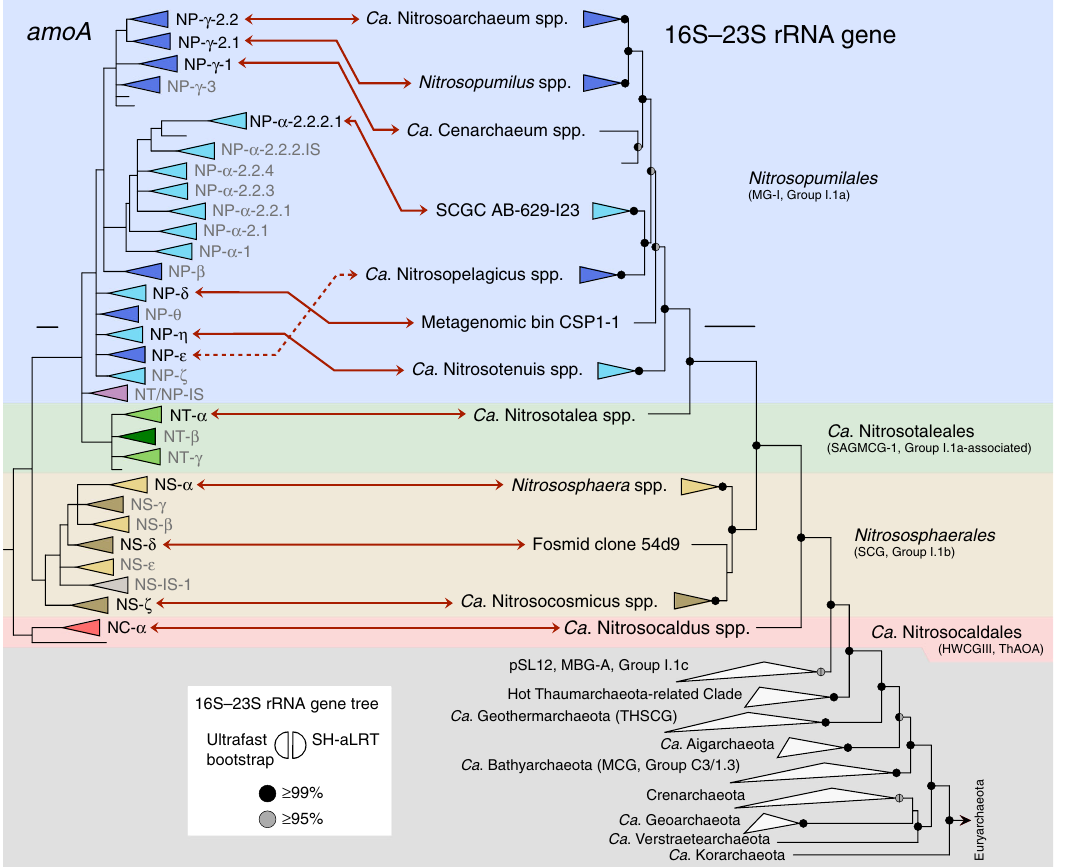
Fig. 2 Congruency between amoA and concatenated 16S – 23S rRNA gene phylogenies of AOA. The amoA tree represents a collapsed display of the tree in Fig. 1, and all branches shown have ultrafast bootstrap 37 ≥ 95% and SH-aLRT 38 ≥ 85%. The rRNA phylogenetic tree was inferred from 92 concatenated 16S and 23S rRNA gene sequences (4628 aligned positions), including representatives of all known Thaumarchaeota and TACK candidate phyla, all Crenarchaeota genera, and 8 Euryarchaeota classes (outgroup). Taxonomic orders of class Nitrososphaeria (i.e., AOA) are indicated by coloured backgrounds and the grey area represents other TACK archaea. Solid and dashed red arrows indicate corresponding amoA and rRNA gene lineages with congruent/compatible or con fl icting topologies, respectively. Labels of amoA clades without known rRNA genes are shown in grey. An uncollapsed display of the rRNA gene tree is depicted in Supplementary Fig. 2; detailed AOA taxonomy and sequence accession numbers are provided in Supplementary Table 1. Names in brackets represent alternative nomenclatures in the literature. rRNA gene sequence alignments were based on archaea-speci fi c structurally accurate seed alignments, and the tree was inferred by maximum likelihood with IQ-TREE 80 based on the GTR + F + R6 model with gene partitions using an edge-unlinked partition model 93 . Support values for branches with both ultrafast bootstrap 37 and SH-aLRT 38 >95% (1000 replicates) are indicated by semi-circles. Scale bars represent 0.1 substitutions per nucleotide position. MG-I Marine Group I, SAGMCG-1 South African Gold